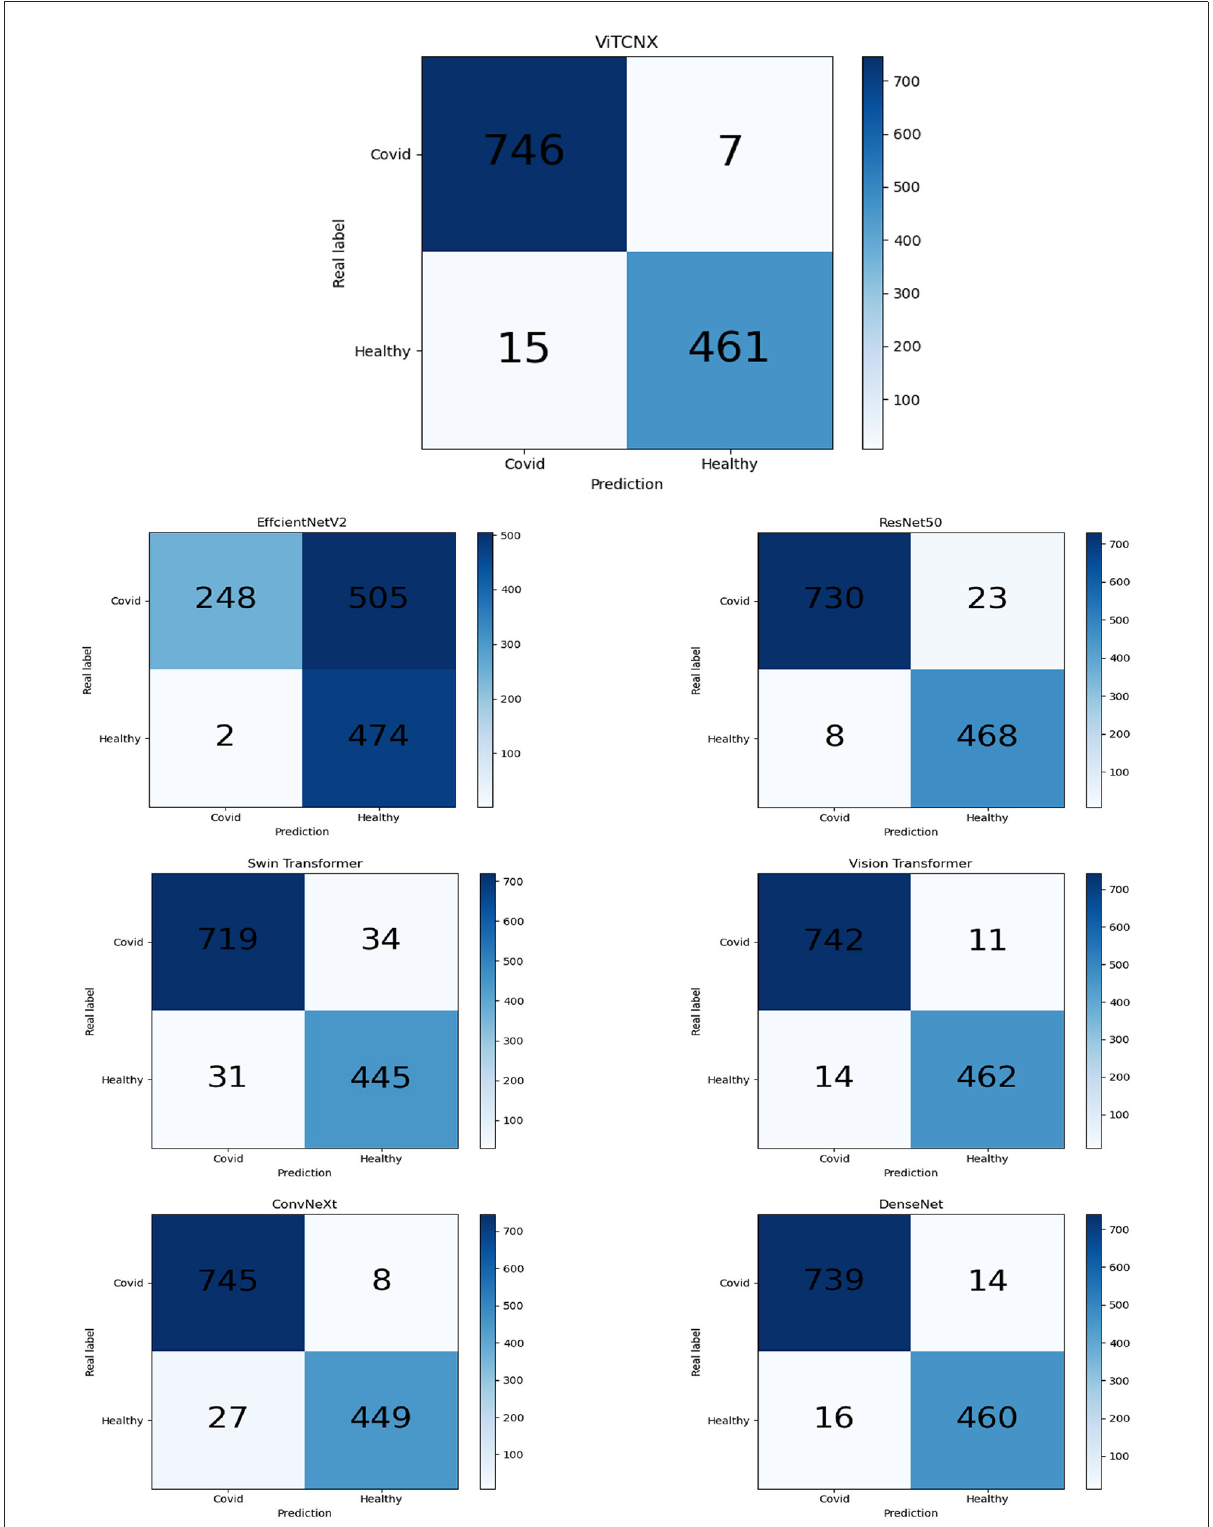
FIGURE9 The confusion matrix of results of VitCNX and six other